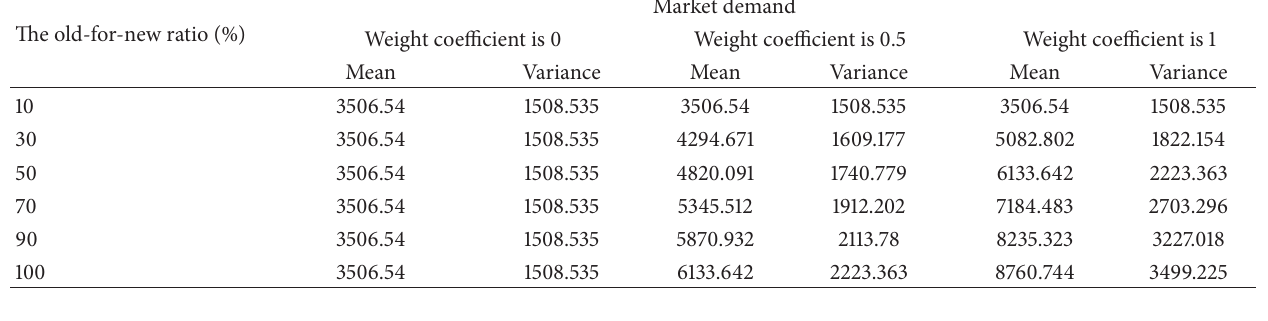
Table 2: The old-for-new policy impact on market demand.